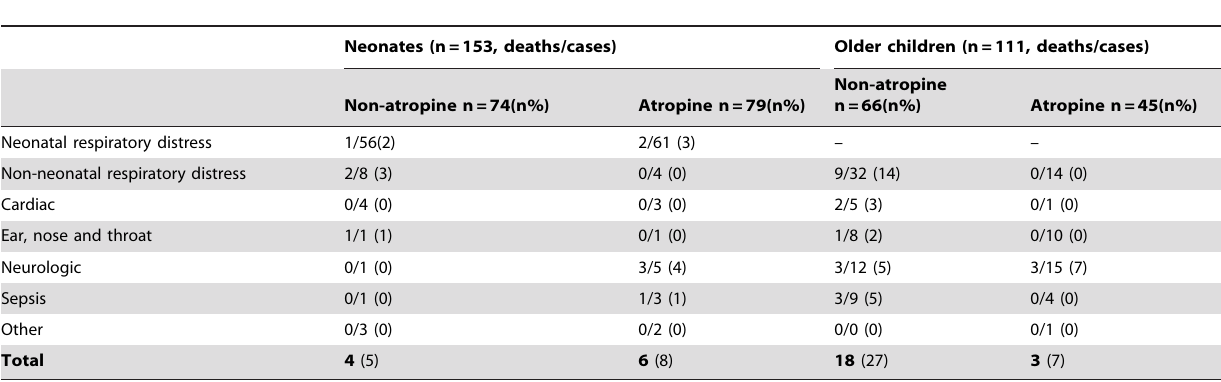
Table 2. Breakdown of the causes of death by pathology. Neonates are # 28 days and older children . 28 days and less than 8 years.